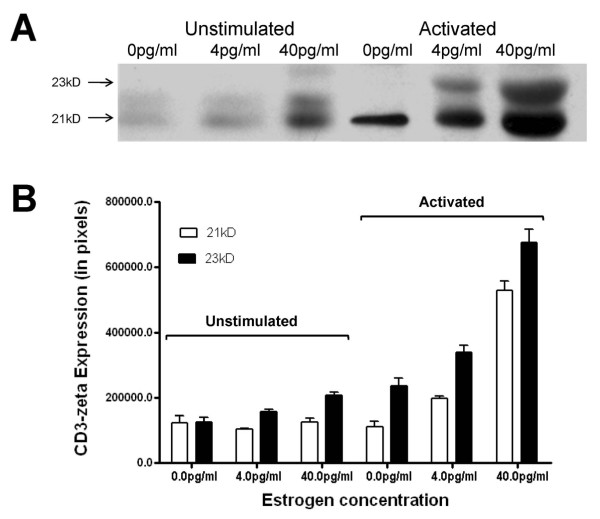
Activation-induced phosphorylation of CD3-zeta at physiologic estradiol concentrations. Representative western immunoblotting results demonstrating the major phosphorylated CD3-zeta bands. Jurkat cells were incubated for 48 hours in 0, 4 or 40 pg/ml estradiol and then activated by cross-linking the TcR. Cellular CD3-zeta was immunoprecipitated and the phosphorylated bands were identified using anti-pCD3-zeta as the primary antibody.